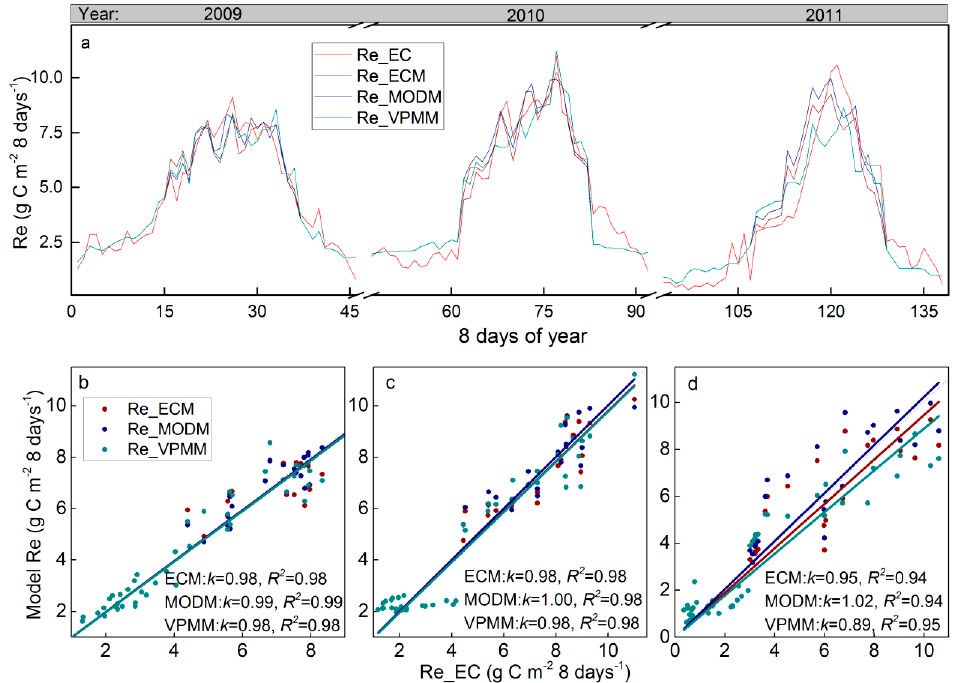
Figure 6. Seasonal variations of ecosystem respiration (Re) estimations from different methods ( a ); and comparison with eddy covariance partitioned Re (Re_EC) from: 2009 ( b ); 2010 ( c ); and 2011 ( d ). k values and dashed lines in ( b – d ) are the linear slope between Re_EC and modeled Re, and the reference lines of 1:1, respectively. All linear regressions are extremely significant ( p < 0.0001). Colors in ( b – d ) are one-to-one corresponding with different Re estimations in ( a ), respectively. Different Re estimations based on the diverse GPP estimation models are identical to the Figure 1.